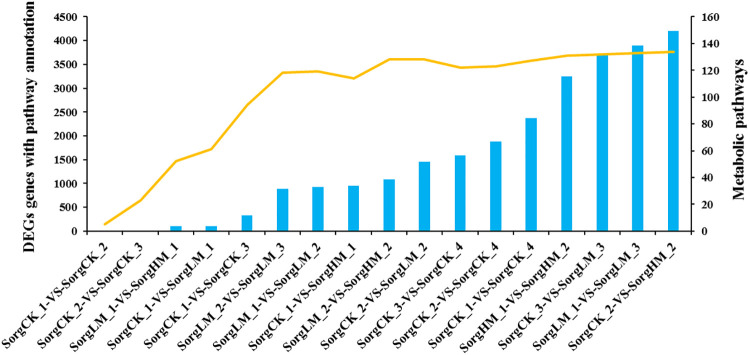
Functional analysis of differential expression gene pathway in sample contrast group.X-axis represents different VS groups. Y-axis represents the number of DEGS and metabolic pathways in each VS groups. SorgCK_1, SorgCK_2, SorgCK_3 and SorgCK_4 represented samples treated with 0 mmol/L MeJA at 19:00 (1h), 20:30 (2.5h), 22:30 (2.5h) and 0:30 (6.5h), respectively. SorgHM_1 and SorgHM_2 represented samples treated with 2.0 mmol/L MeJA at 19:00 (1h) and 20:30 (2.5h), respectively. SorgLM_1, SorgLM_2 and SorgLM_3 represented samples treated with 0.5 mmol/L MeJA at 19:00 (1h), 20:30 (2.5h) and 22:30 (4.5h), respectively.